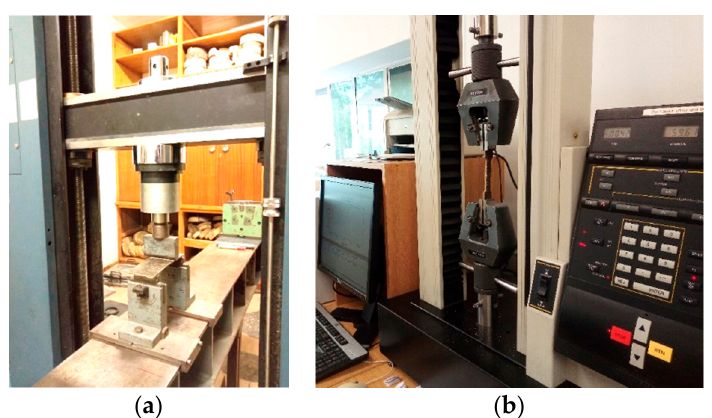
Figure 6. Instron setup for ( a ) the 3-point bending test, and ( b ) tensile test.